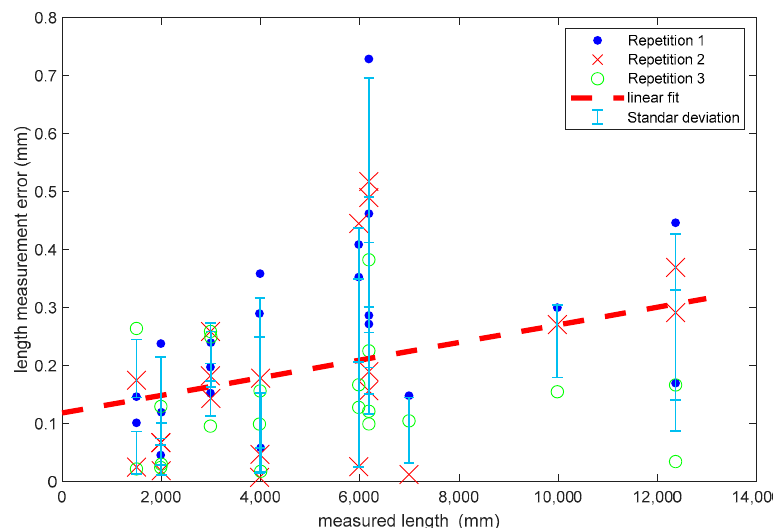
Figure 8. Errors of the deficient network and high-level extrinsic parameters.